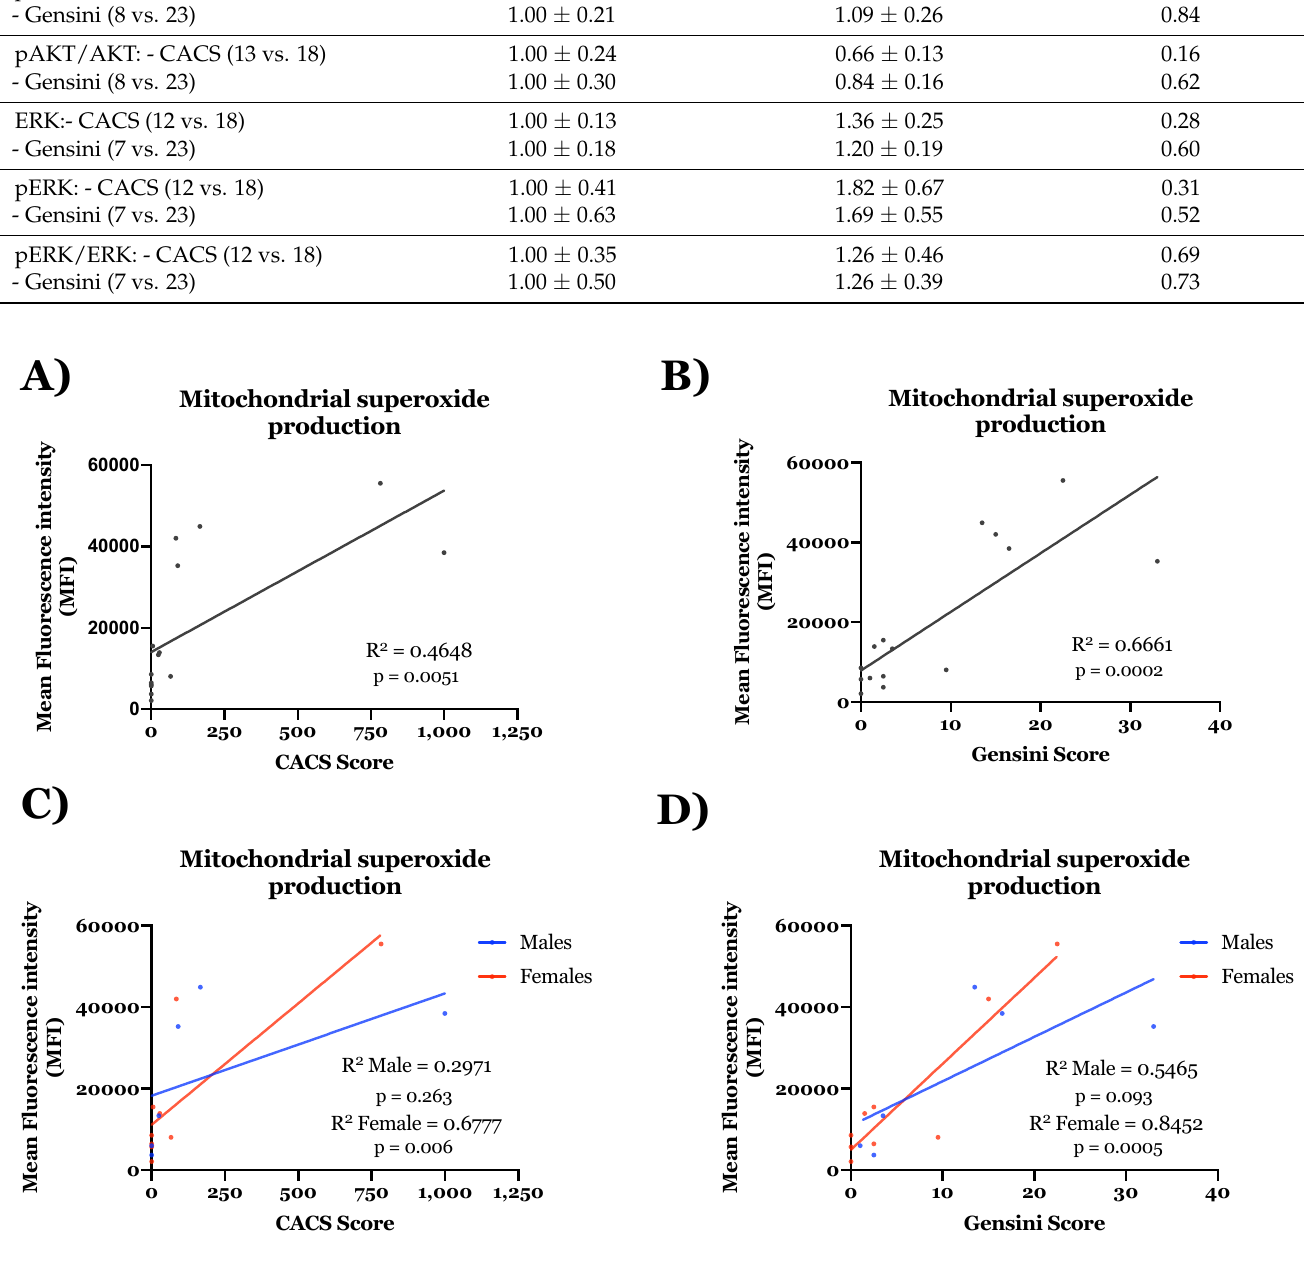
Figure 5. The mitochondrial production of superoxide is correlated to the severity of CAD. MitoSOX analyses were performed in ECFCs from patients with or without CAD to measure the mitochondrial production of superoxide. The presence of CAD was determined using CACS or Gensini score ( A , B ). Groups were split between females and males ( C , D ). Results are expressed as Mean Fluorescence Intensity (MFI). ( A , B ) show the results of both sexes of patients with or without CAD classified by either CACS or Gensini score respectively. ( C , D ) show the same results but sex segregated. Statistical correlations were derived using bivariate linear regression analysis. n = 15: male 6 and female